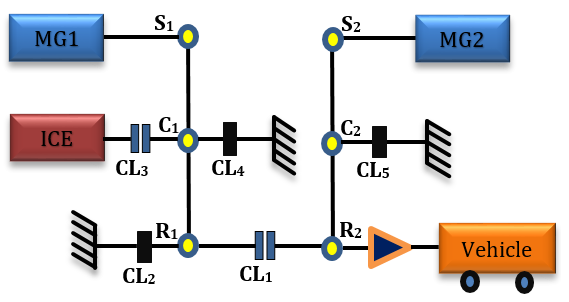
Figure 3. Topology of the drivetrain with two planetary gears used in this